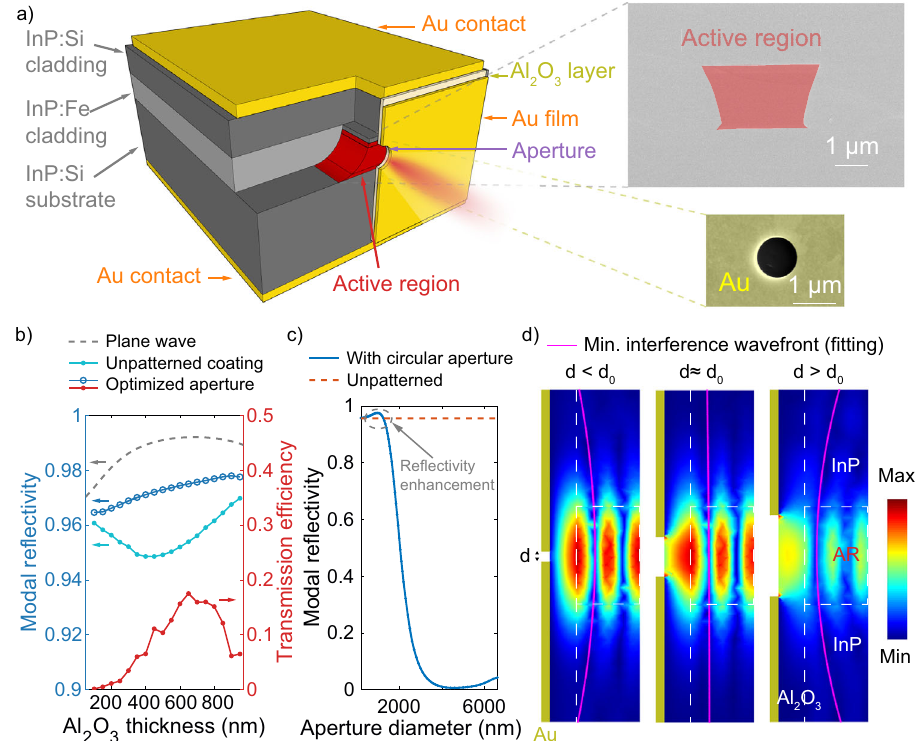
Fig. 1 Laser design and theoretical results of the re fl ectivity enhancement. a Illustrative image of the semiconductor laser structure where a hole is introduced in its front metallic coating. Here only half of the front coating is shown and the active region is drawn as exposed for a clear illustration. In the actual device, the active region is fully buried by the cladding and the coating fully covers the facet. An SEM photo of the laser facet before depositing the metallic coating is shown in the upper right inset. The lower right inset shows the SEM image of the highly re fl ective coating with a circular hole patterned by the focused ion beam milling. The aperture diameter is around 950 nm. The SEM images are colored manually. b Coating modal re fl ectivity simulated with varying thickness of the dielectric layer in three different cases, including the ideal plane-wave case (gray, dashed line), the case with a laser waveguide but without an aperture (light blue dotted line), and the case with a waveguide and a circular aperture through the metallic fi lm of which the aperture size is optimized for each Al 2 O 3 thickness (dark blue circled line). The red dotted line shows the transmission ef fi ciency as a function of the Al 2 O 3 thickness for the case with the circular aperture. The optical wavelength in the simulations is set as 4.5 μ m. c Coating modal re fl ectivity with varying hole diameter, where the insulating layer thickness is set as λ /4. The straight dashed red line shows the re fl ectivity of the coating without an aperture. The dashed gray circle shows the region where the modal re fl ectivity is enhanced by the presence of the aperture. d Simulated fi eld patterns of the coated laser facet using three different hole diameters. Shown in these plots are the amplitude of the vertical component of the electric fi eld ∣ E z ∣ . Here the pink lines are the fi tted curves for the minimum interference, showing the curvature of the optical wave front in each case. Parameter d is the aperture diameter and d 0 is the diameter with the maximum modal re fl ectivity. In the three cases, the hole diameter is (from left to right): 250, 1000, 2000 nm, respectively. The color bar ranges in ( d ) are [1.7 × 10 4 , 2.5 × 10 7 ], [2.1 × 10 4 , 2.7 × 10 7 ], [5.5 × 10 4 , 4.0 × 10 7 ] (arbitrary units), respectively. ⓒ 2021 IEEE. Figure 1 is reprinted, with permission, from ref. 20